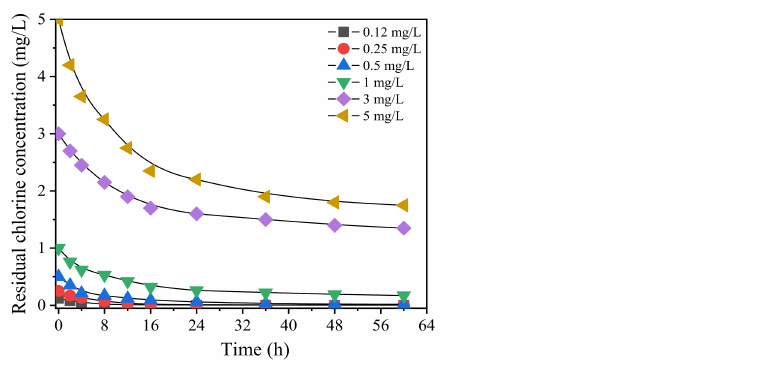
Figure 1. Correlation between initial chlorine concentration and residual chlorine